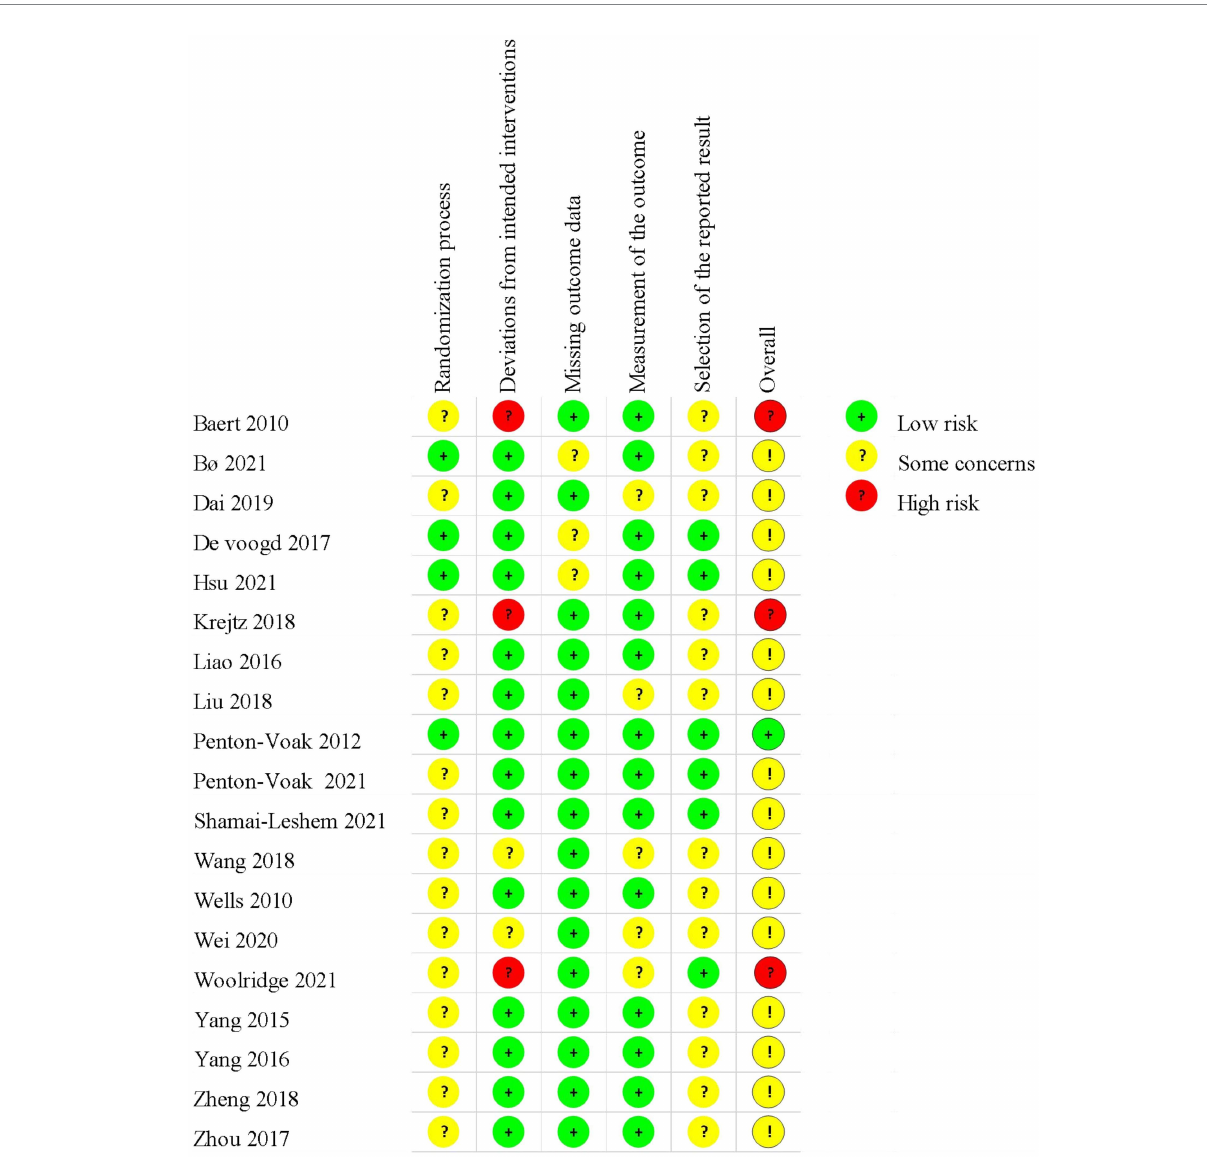
FIGURE 2 Results of risk-of-bias (RoB 2.0) assessment. The plot of RoB 2.0 for each included study.